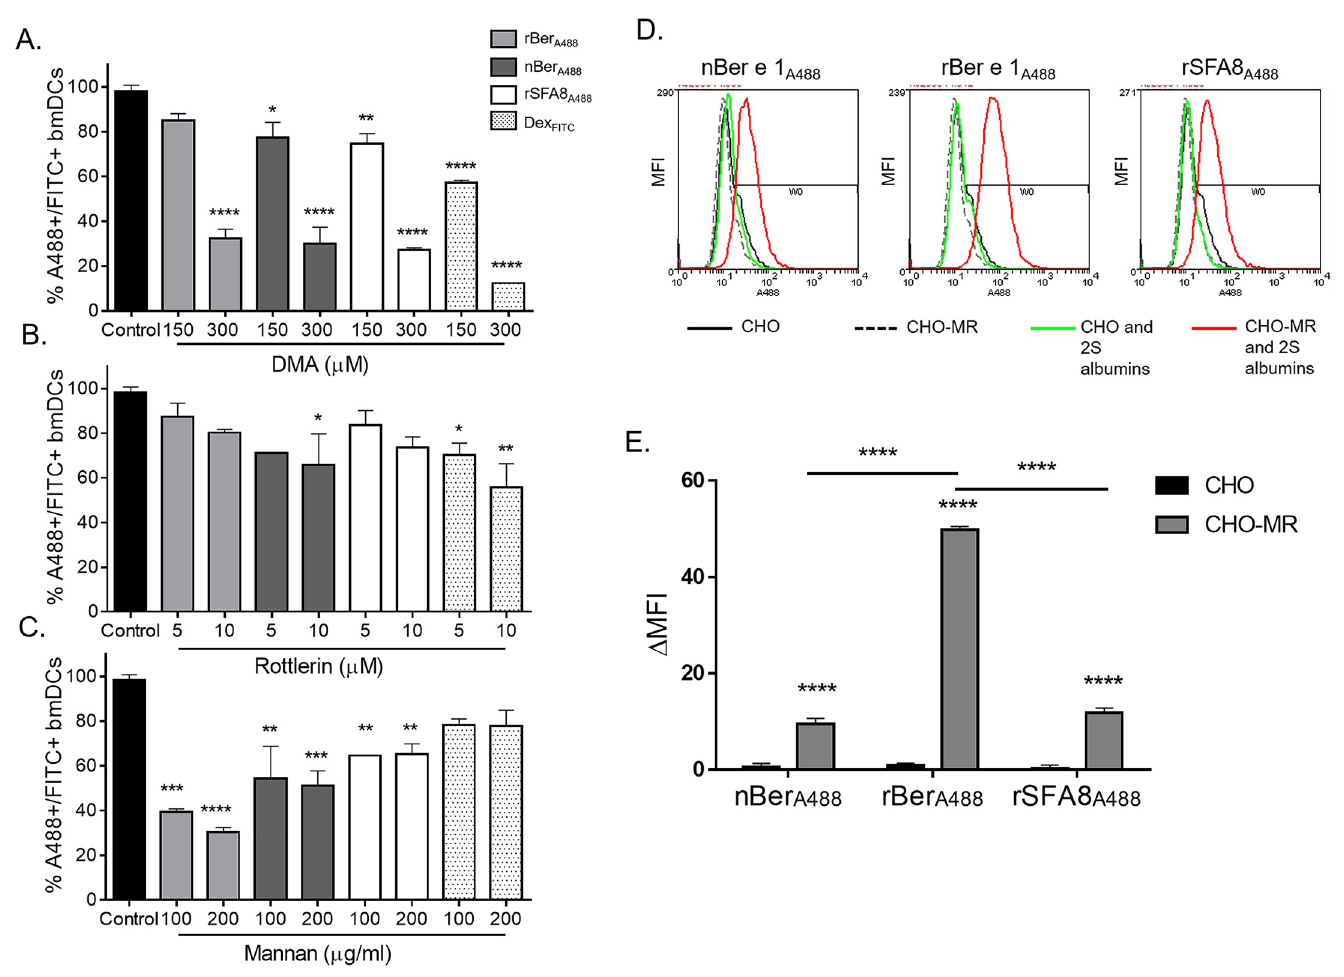
Fig 4. Mechanisms of endocytosis of 2S albumins in bmDC and their uptake in CHO and CHO-MR. (A.) The effect of macropinocytosis inhibitors, DMA and (B.) rottlerin, and (C.) mannose competitive inhibitor, mannan, on the endocytosis of rBer e 1-A488, nBer e 1-A488 and rSFA8-A488 into bmDC was determined by flow cytometry. (D.) The flow cytometry histogram of uptake of A488-labelled proteins by CHO and CHO-MR cell line, as analysed using flow cytometry (E.) The graph showed differences in the uptake of fluorescent-labelled rBer e 1, nBer e 1 and rSFA8 by CHO and CHO-MR where data are presented as normalised median fluorescent intensity (MFI) of cells pulsed with labelled proteins to unpulsed cells and presented as mean ± SD. �� p < 0.01, ��� p < 0.001, ���� p < 0.0001. Statistical differences are relative to the untreated control.